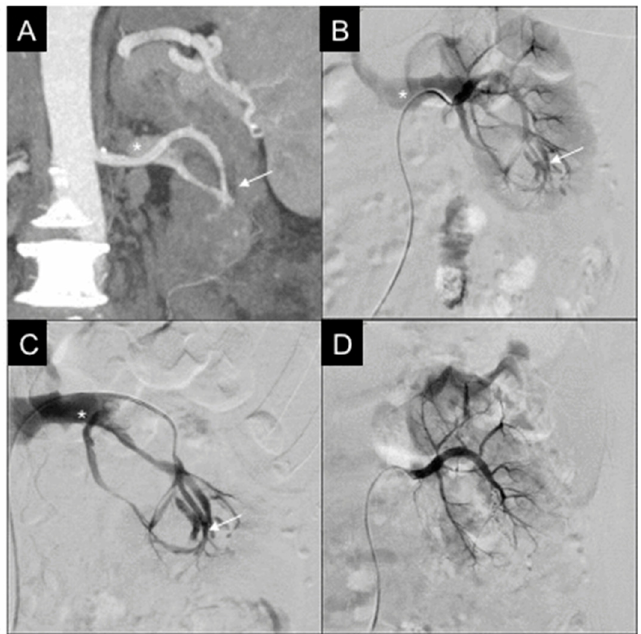
Figure 2. 57-year-old female, affected by iatrogenic arteriovenous fistula (AVF). ( A ) CT reconstruction with MIP and coronal MPR, in arterial phase: intraparenchymal AVF (white arrow) at the inferior third of the left kidney, with early opacification of the left renal vein (white asterisk). ( B ) Selective right renal DSA confirms AVF (white arrow), left renal vein opacified in early phase of injection (white asterisk). ( C ) Selective catheterization of the inferior third, up to the AVF (white arrow) with evidence of the renal vein (white asterisk). ( D ) Final DSA showing AVF resolution after embolization with two pushable microcoils (MicroNester 4 mm), renal parenchyma being vascularized, renal vein no longer opacified.